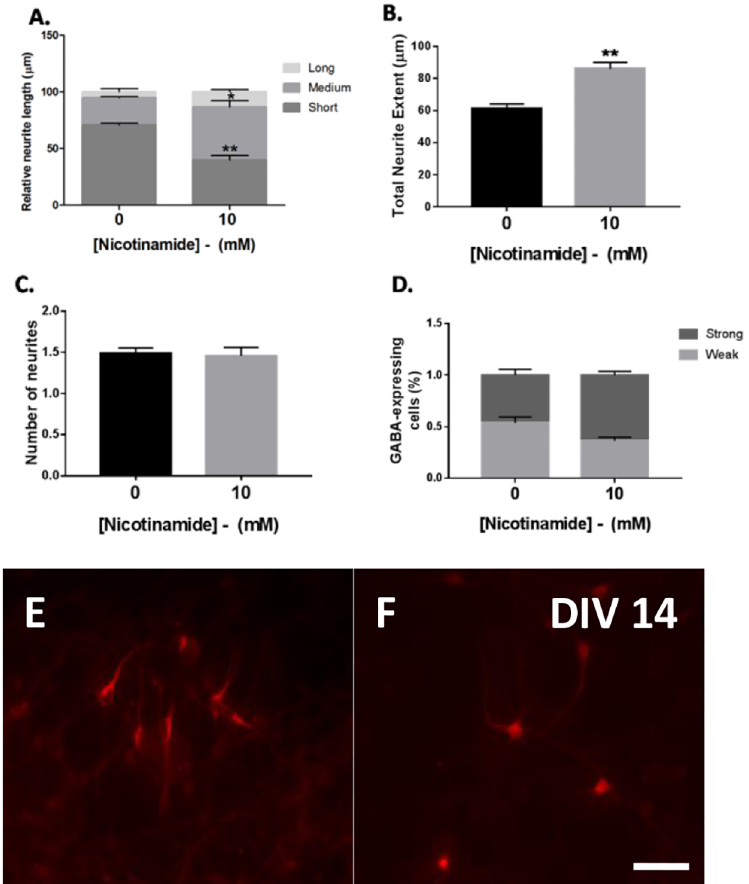
Fig 5. Nicotinamide enhanced neuronal maturation in GABAergic populations. (A and E) The proportionof 46C-derived cells displaying“short” primary processes was significantly decreasedin cultures exposedto 10 mM nicotinamide betweendays 0 and 7, concomitant with an obvious increasedtrend for “longer”neurite processes, comparedwith controls (F). (B) Total length of neurites was significantly increased in the presenceof nicotinamide. (C) There was no difference in the number of primary neurites per neurons betweencontrols and nicotinamide-stimulated conditions. (D) An upwardtrend in the proportionof mESC- derived cells displaying“strong” levels of GABA expressionwas demonstrated in cultures exposedto 10 mM nicotinamide, which correlated with a downward trend in “weaker”-expressing GABAergic cells, compared with control conditions. *** p < 0.001, ** p < 0.01, * p < 0.05.Micrographs show morphologiesof GABA+ neurons differentiated in control conditions (E), or cultures treated with 10 mM nicotinamide (F). Scale bar = 100 μ